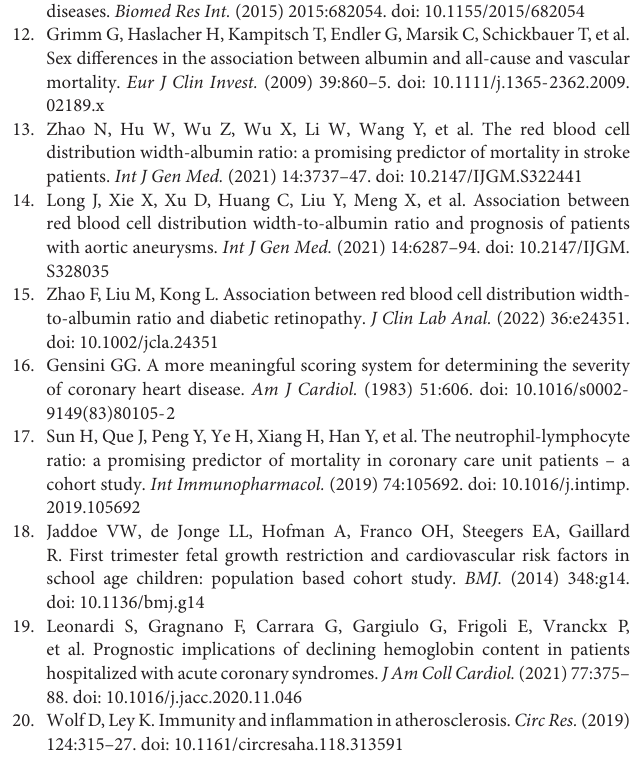
Supplementary Figure 3 | Kaplan–Meier survival from in 30-day all-cause mortality for patients in RA tertiles. Q1, RA < 3.7 ml/g; Q2, RA was 3.7–4.5 ml/g; Q3, RA > 4.5 ml/g. Supplementary Figure 4 | Kaplan–Meier survival from in 1-year all-cause mortality for patients in RA tertiles. Q1, RA < 3.7 ml/g; Q2, RA was 3.7–4.5 ml/g; Q3, RA > 4.5 ml/g. Supplementary Table 1 | Gensini score rule. Supplementary Table 2 | Baseline characteristics of the study population. Supplementary Table 3 | Baseline characteristics of the study